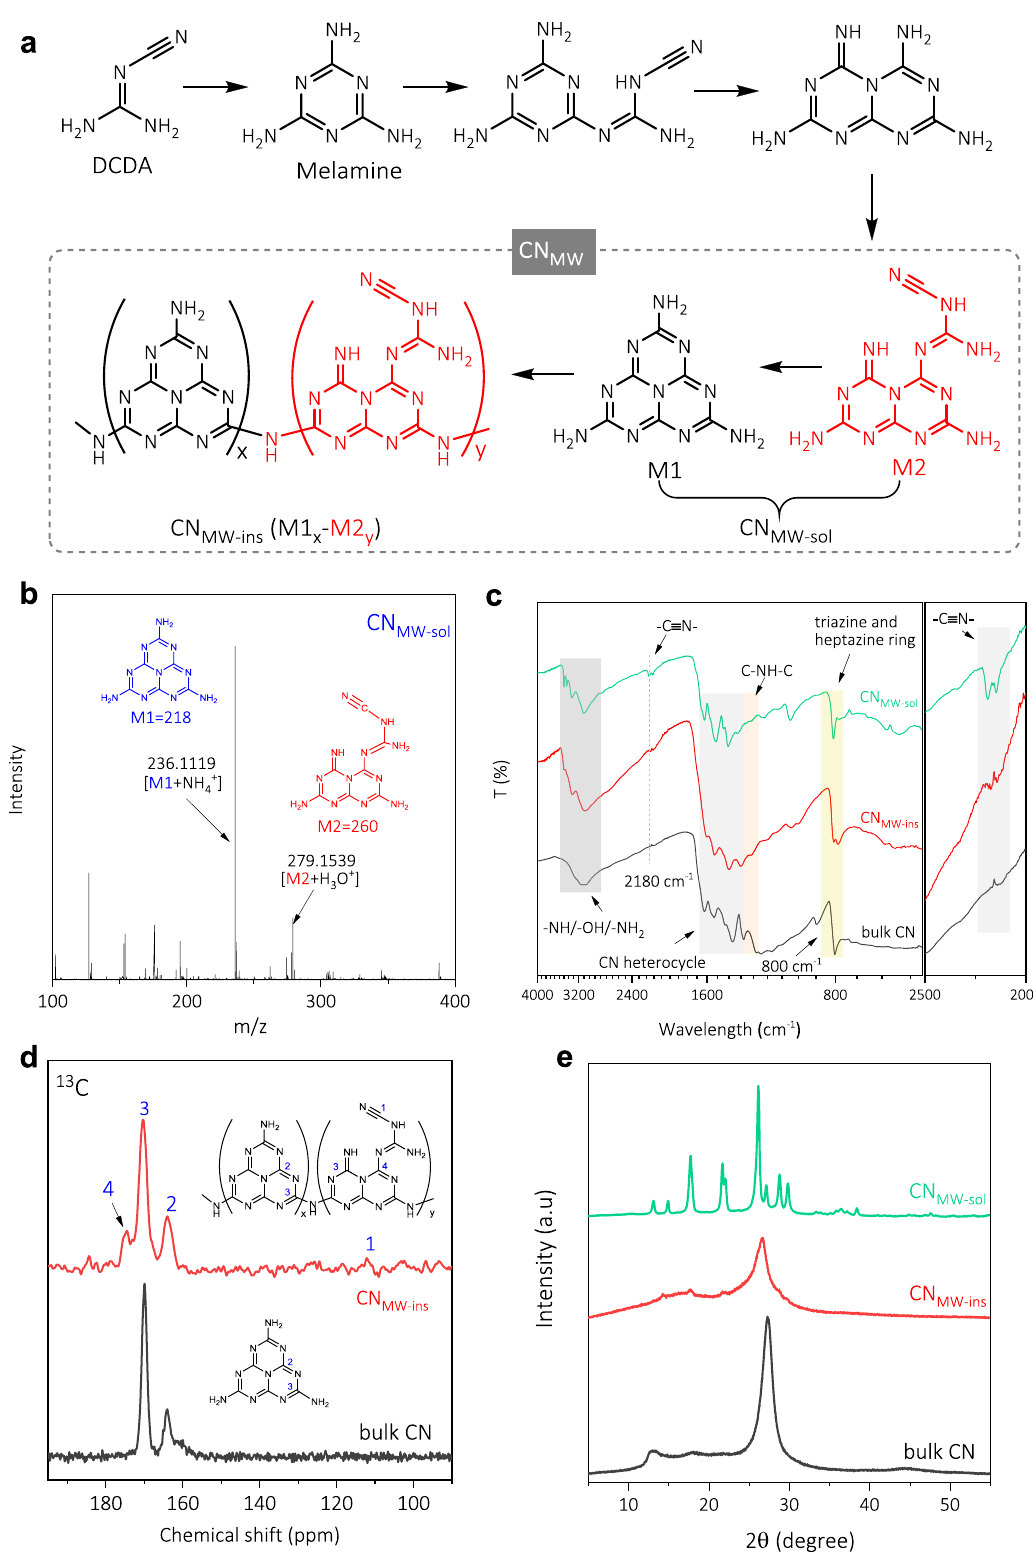
Fig. 1 Structural characterizations of CN MW-ins and CN MW-sol . a Scheme of the general recognized condensation processes for CN MW . b Q-TOF mass spectrum of CN MW-sol . c FT-IR of CN MW-ins , CN MW-sol , and traditional bulk CN. d 13 C NMR spectra of CN MW-ins and bulk CN. e Normalized XRD patterns of CN MW-ins , CN MW-sol , and traditional bulk CN.